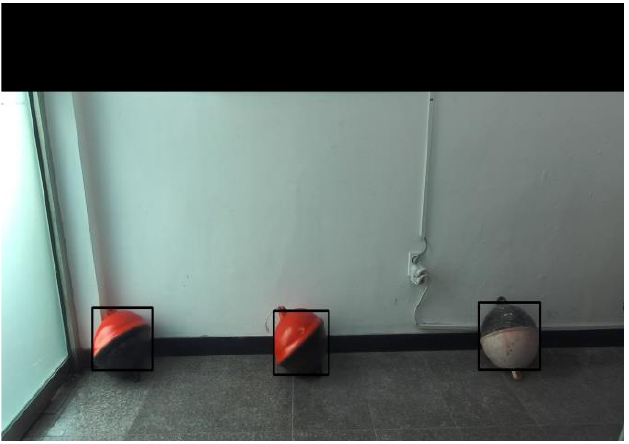
Figure 16. Key point matching by ORB (Experiment A).